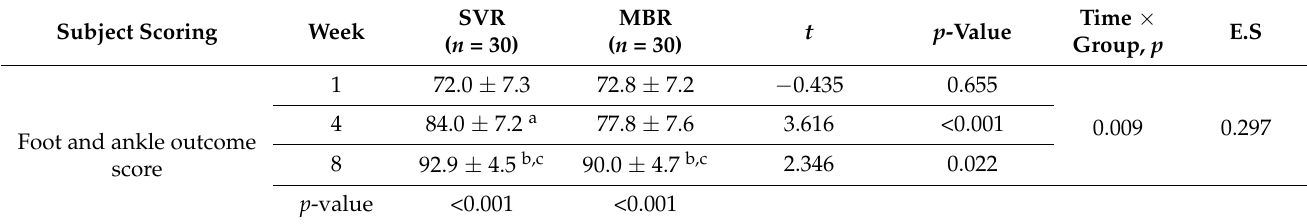
Table 3. Foot and Ankle Outcome Score.